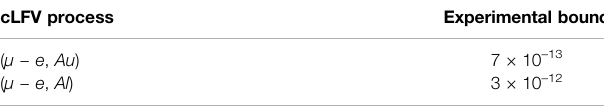
TABLE 2 | Experimental bounds for the process CR ( μ − e , N )